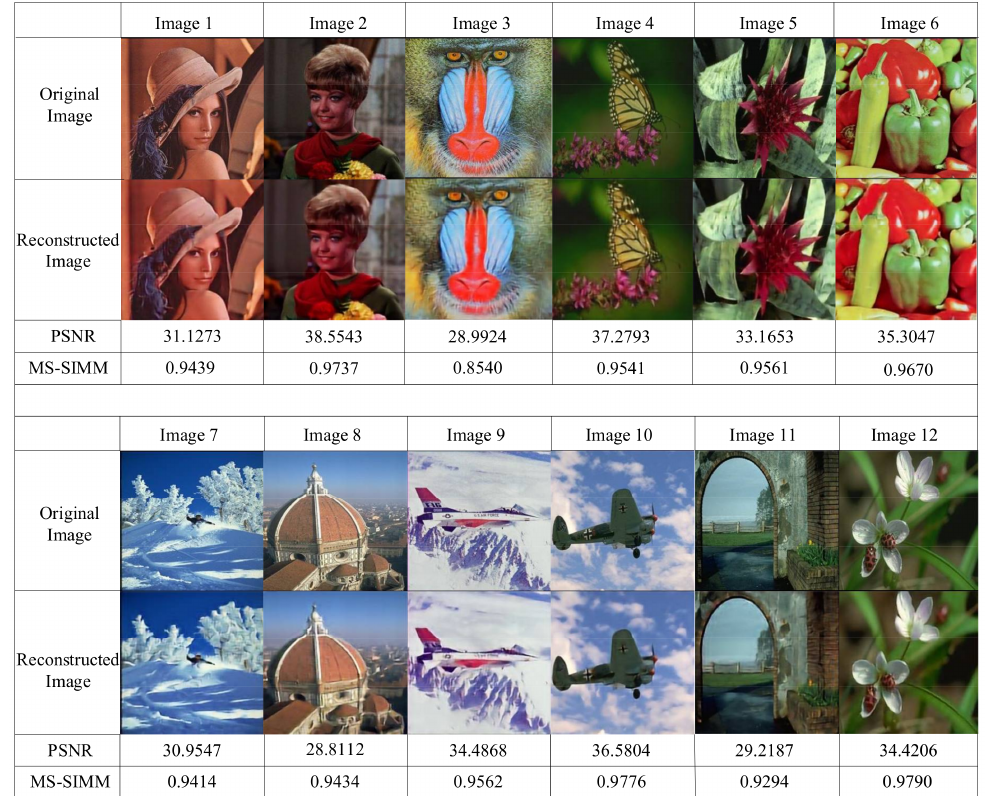
Figure 7. Original and reconstructed